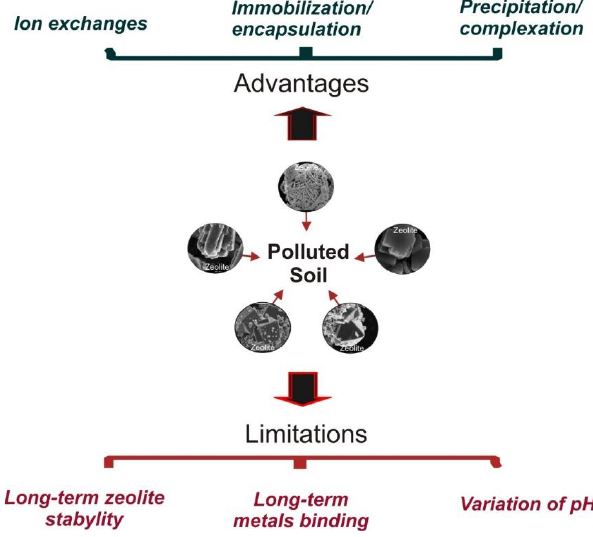
Figure 7. Zeolites and soil pollution: advantages and limitations.